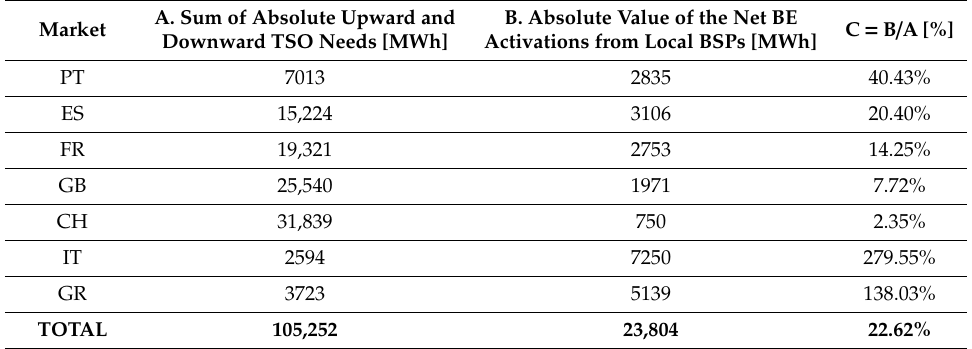
Table 2. E ff ect of imbalance netting in the cleared Balancing Energy (BE) quantities of Balancing Service Providers (BSPs).